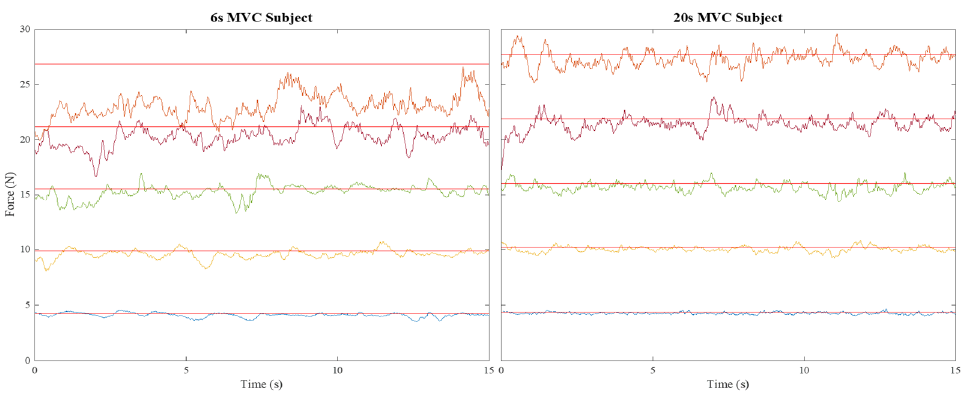
Figure 1. Illustrations of raw force data and corresponding targets at 15%, 35%, 55%, 75%, and 95% MVC in ascending